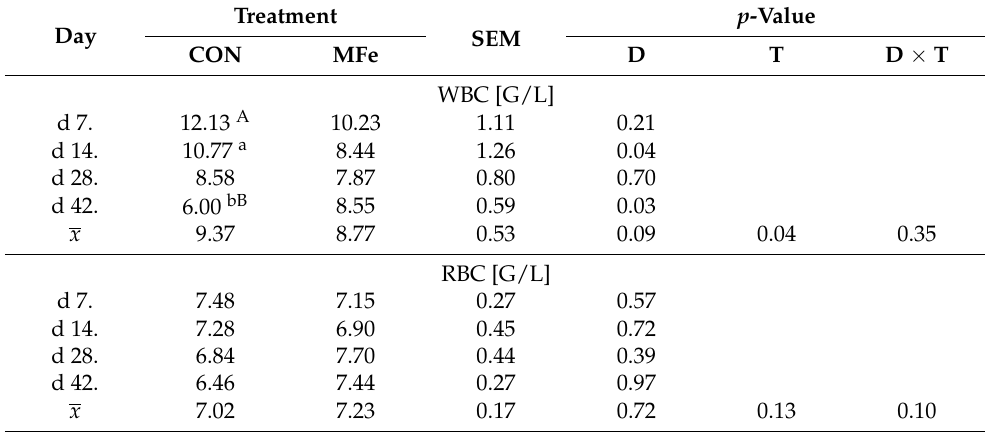
Table 3. Mean values of the hematological parameters with regard to the calves’